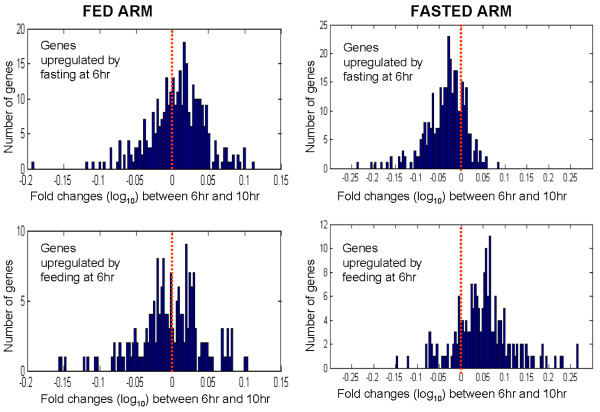
Genes that were differentially regulated between fasting and feeding at the 6 hour time point continue to be regulated at the 10 hour time point for the fasted arm, but not for the fed arm. The left panels show that the 6 hour to 10 hour changes for the fast-fed signature in the fed arm mostly center around zero; the right panels show significant changes for the fast-fed signature in the fasted arm. Subjects in all arms were fed 30 minutes after the 6 hour biopsy time point. Y-axis: number of genes. X-axis: Fold changes (log10) between 6 hour and 10 hour time points.